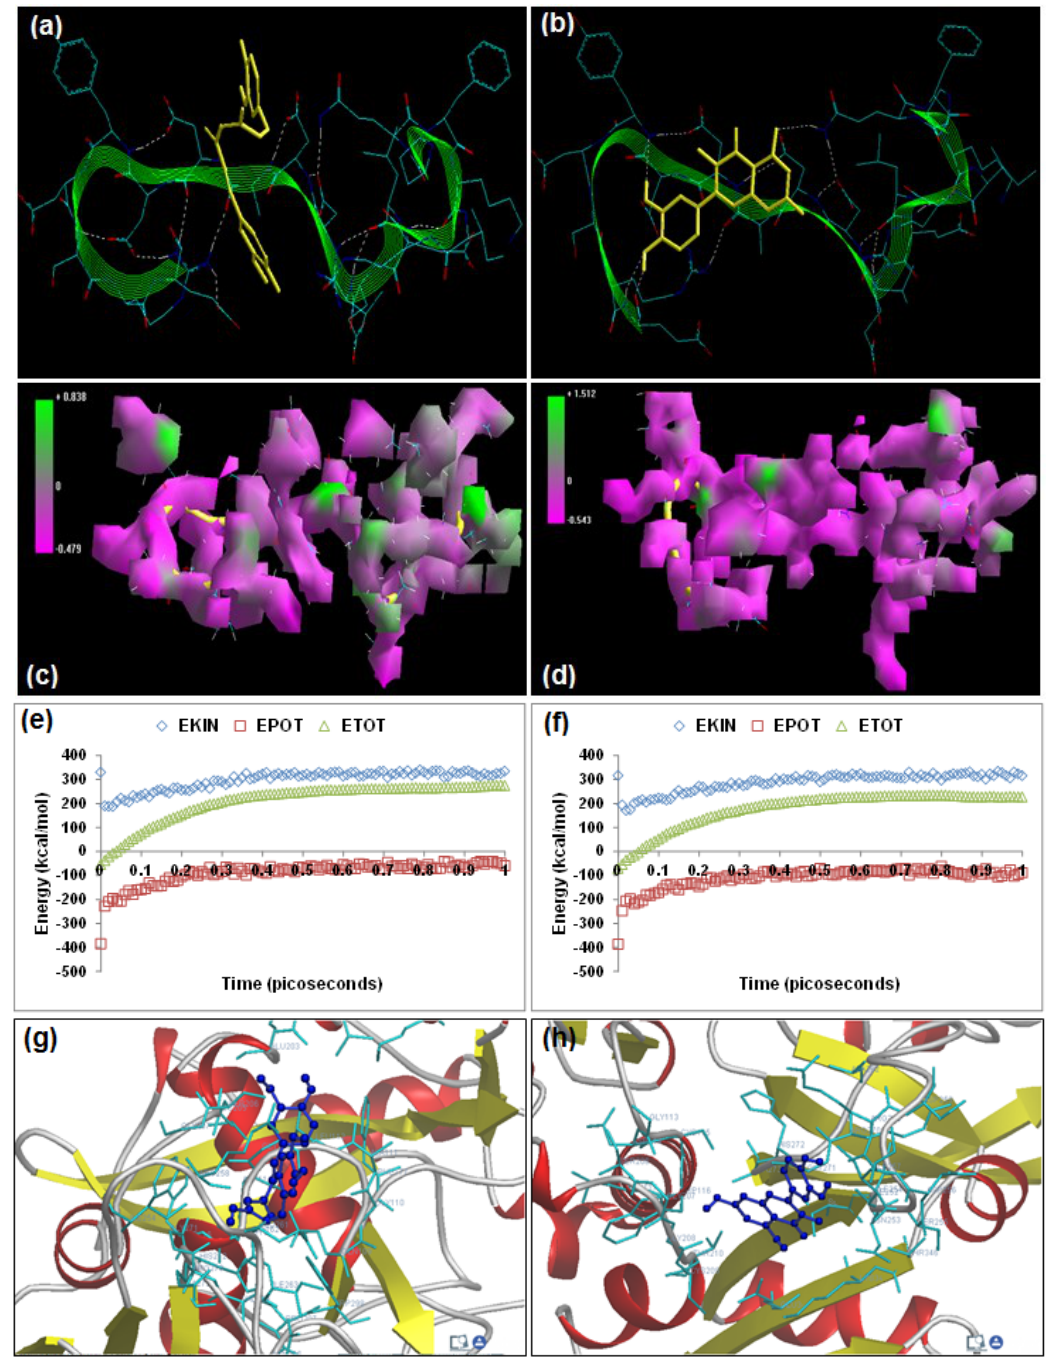
Figure 7. Visualization of the geometrical preferences of the calpain molecule (green secondary structure) in complexation with ligand molecules (yellow tube rendering). ( a ) Curcumin and ( b ) quercetin after molecular mechanics simulations. 3D-mapped isosurface plot representing the electrostatic potential for ( c ) calpain–curcumin and ( d ) calpain–quercetin. The kinetic energy (EKIN), potential energy (EPOT), and total energy (ETOT) values for ( e ) calpain–curcumin and ( f ) calpain–quercetin calculated by molecular dynamic simulations in vacuum. The most favorable poses of ( g ) curcumin and ( h ) quercetin within calpain were obtained via molecular